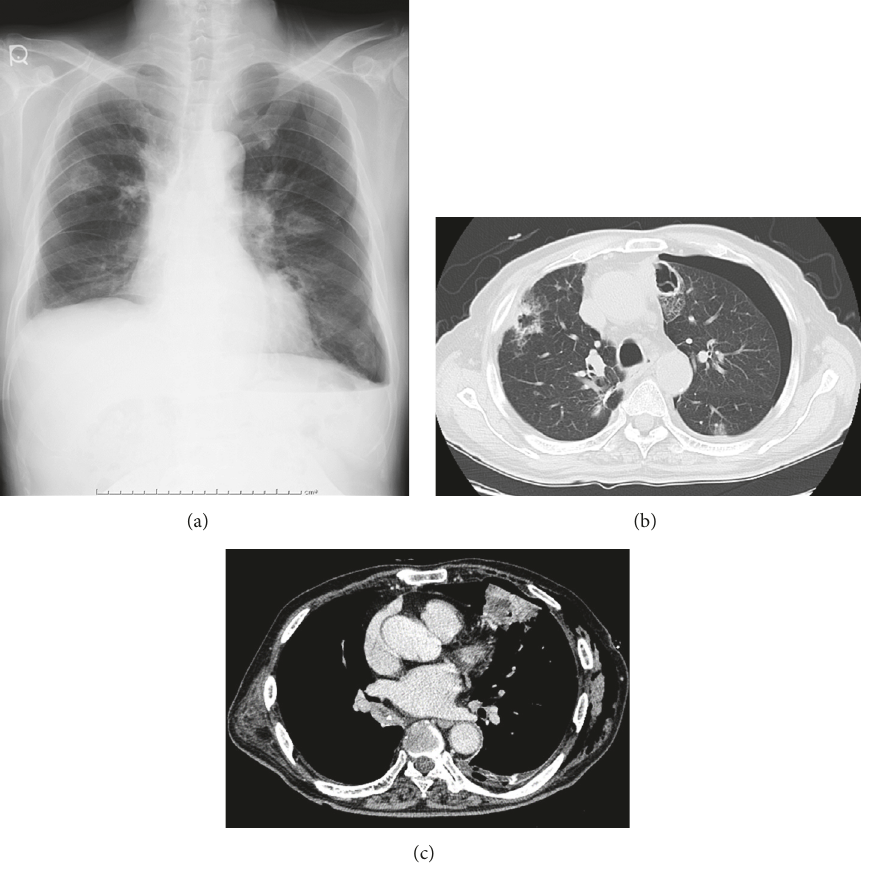
Figure 1: (a) A chest X-ray showed a left pneumothorax and multiple metastases in the bilateral lung. (b) A CT scan of the chest revealed that some nodules with cavities were located in the edge of the lung. (c) A contrast enhanced CT scan of the chest revealed a cavity, culprit lesion of hemoptysis, 25 mm in size, in the left upper lobe.